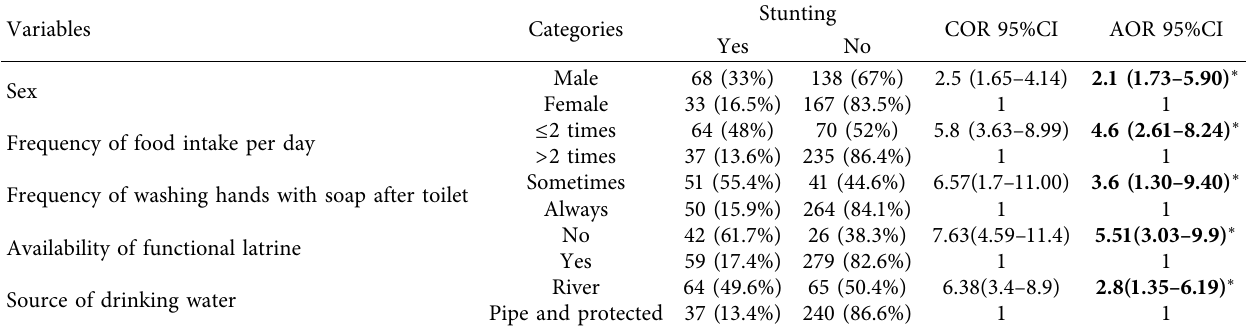
Table 3: Bivariable and multivariable logistic regression analysis on factors associated with stunting among adolescent students in Legehida district, Northeast Ethiopia,